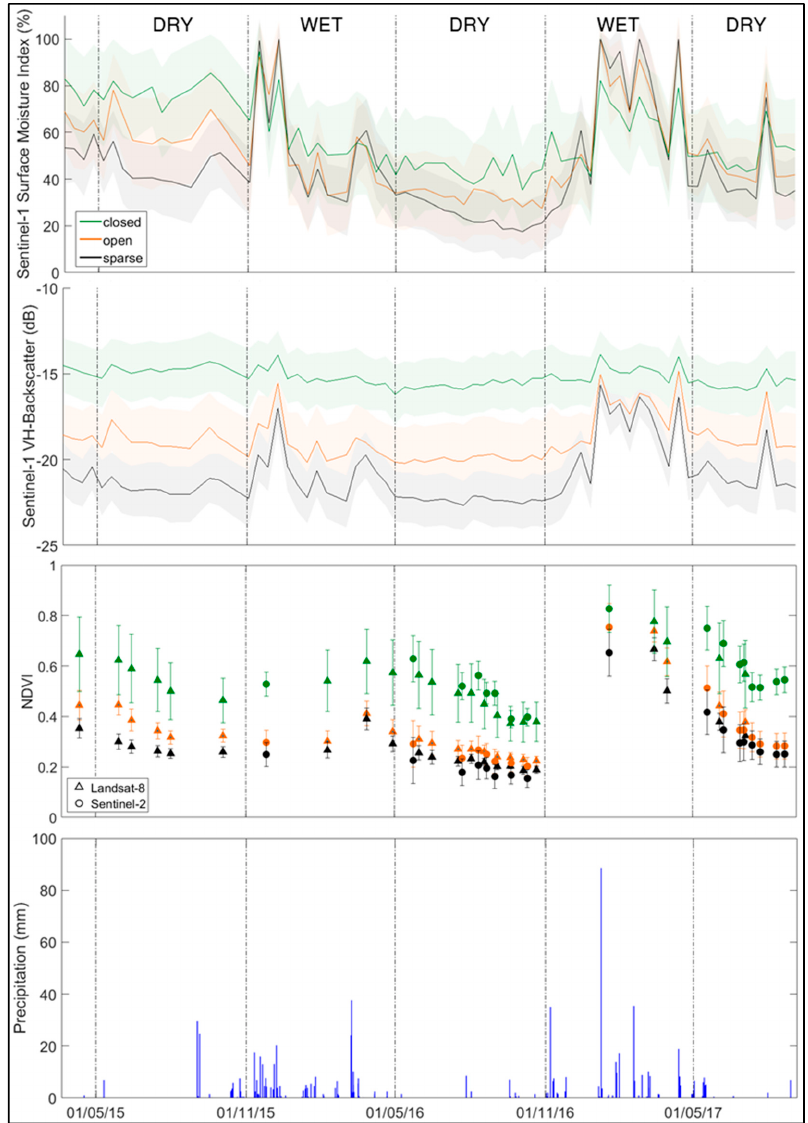
Figure 10. Time series of Sentinel-1 derived moisture index (in %), Sentinel-1 VH backscatter information in dB, NDVI time series derived from Sentinel-2 and Landsat-8, for different land cover units derived by image object segmentation and precipitation in mm records (from top to bottom).